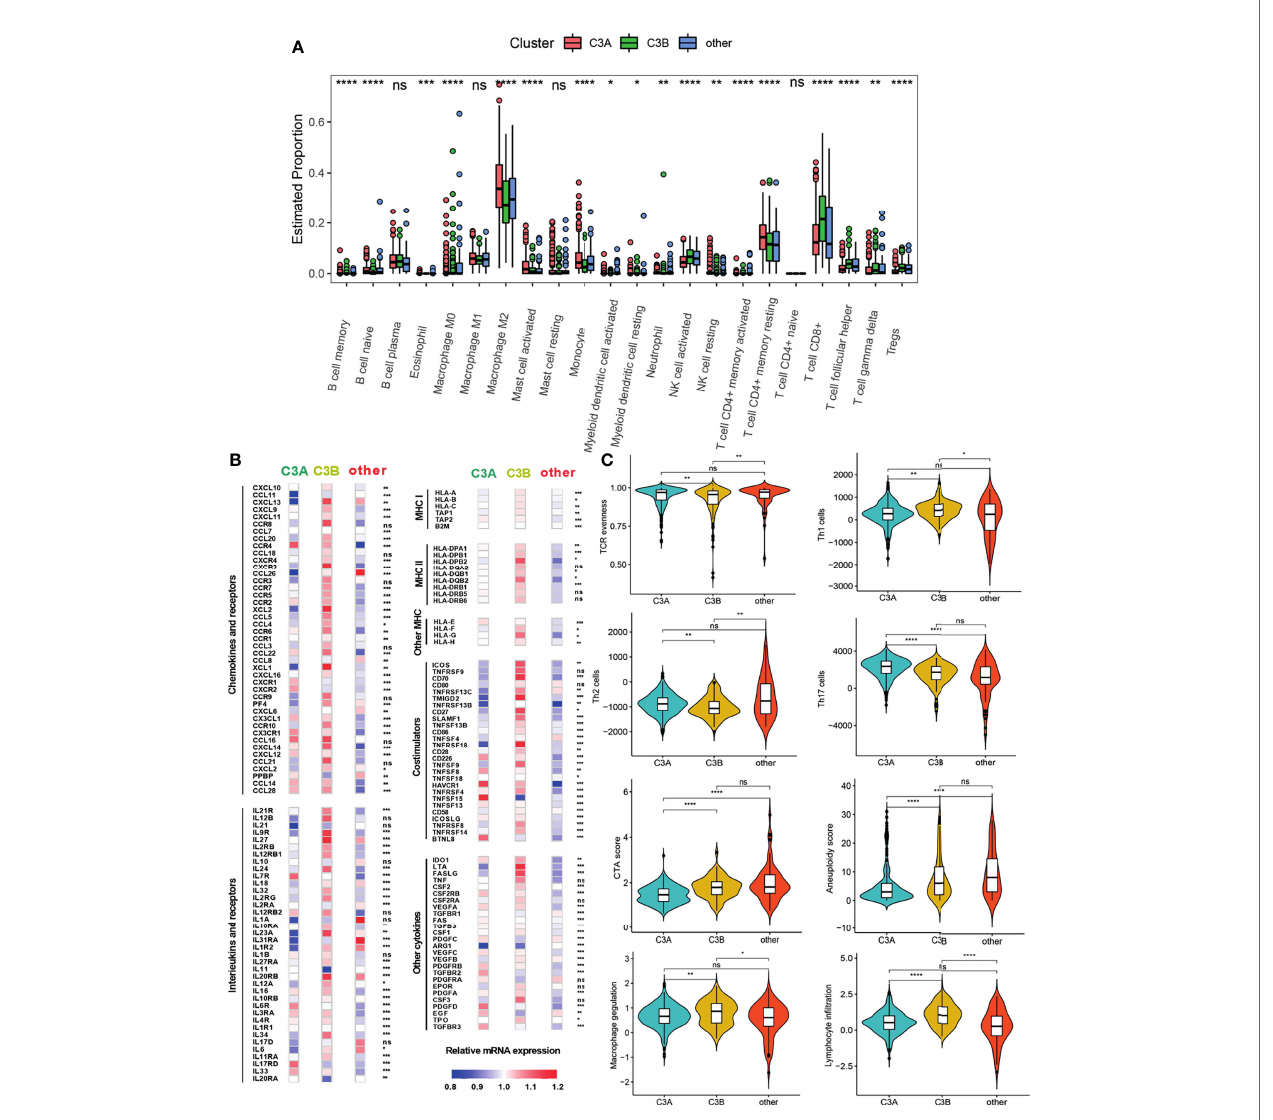
FIGURE 6 | The landscape of the tumor immune microenvironment in different FB-based clusters. (A) Comparison of the abundances of 22 immune cells in different subclusters. (B) Expression of chemokines, interleukins, interferons, MHC molecules, co-stimulators, co-inhibitors, and other important cytokines and their receptors in ccRCC from different subclusters. (C) Different values of vital immune characteristics in different subclusters. ccRCC, clear cell renal cell carcinoma; TCR, T cell receptor; CTA, cancer testis antigens; *p < 0.05; **p < 0.01; ***p < 0.001; ****p < 0.0001; ns, non-signi fi